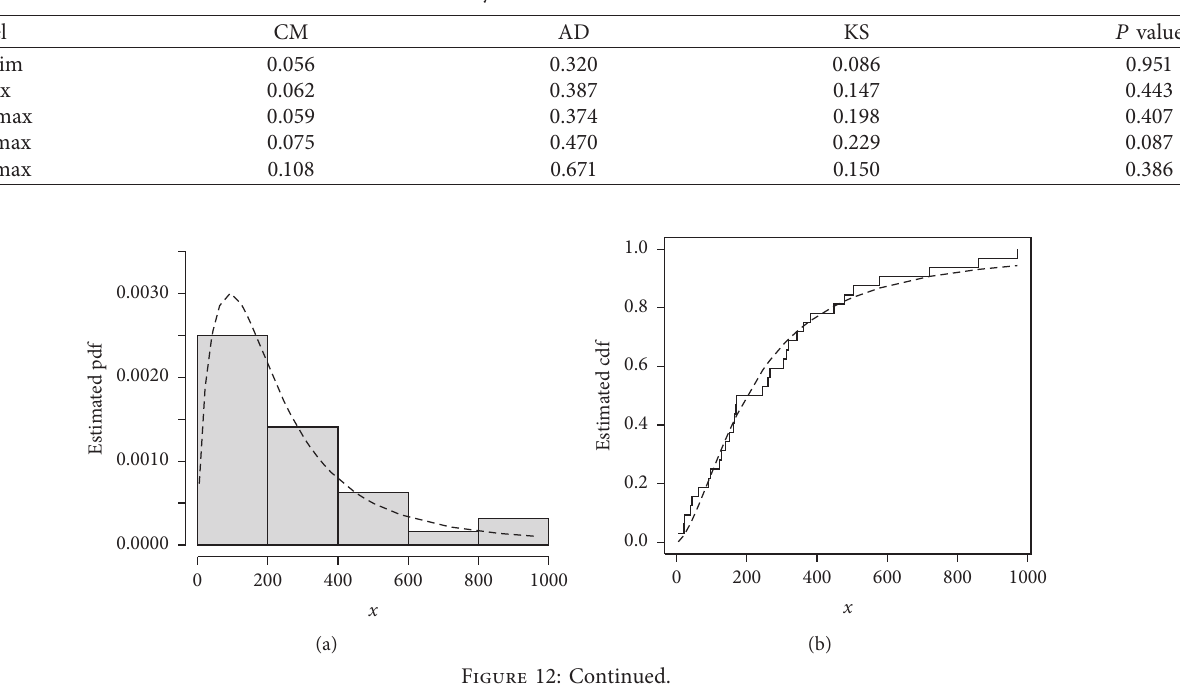
Table 4: The analytical measures of the fitted